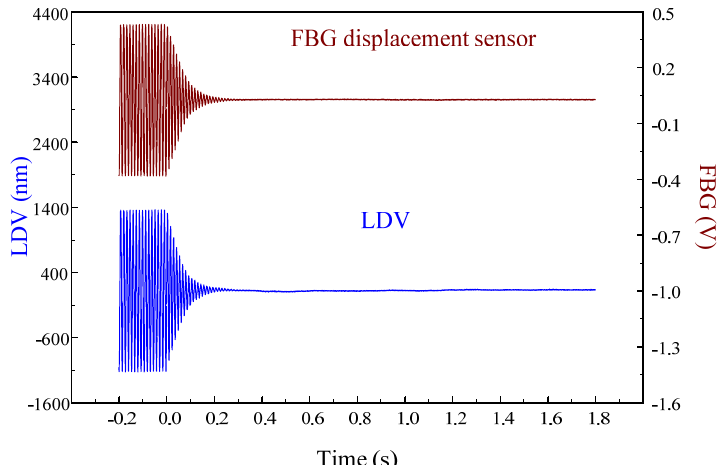
Figure 24. Active vibration control of the smart cantilever beam excited at first resonant frequency (76 Hz) obtained from displacement